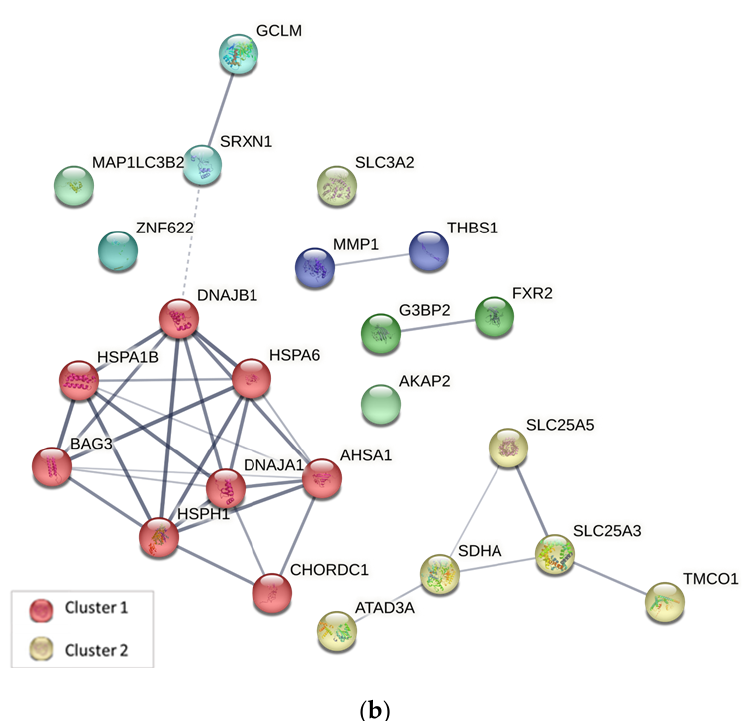
Figure 4. Interaction network for up-regulated proteins of MDA-MB-231 cells in response to treatment with ( a ) CuHL1 and ( b ) CuHL2 generated using the STRING v11.5 database. The thickness of the line indicates the degree of confidence of the interaction. A variety of interaction sources were included into the search strategy, such as text mining, experiment record, database record, coexpression, neighborhood, gene fusion, and co-occurrence.